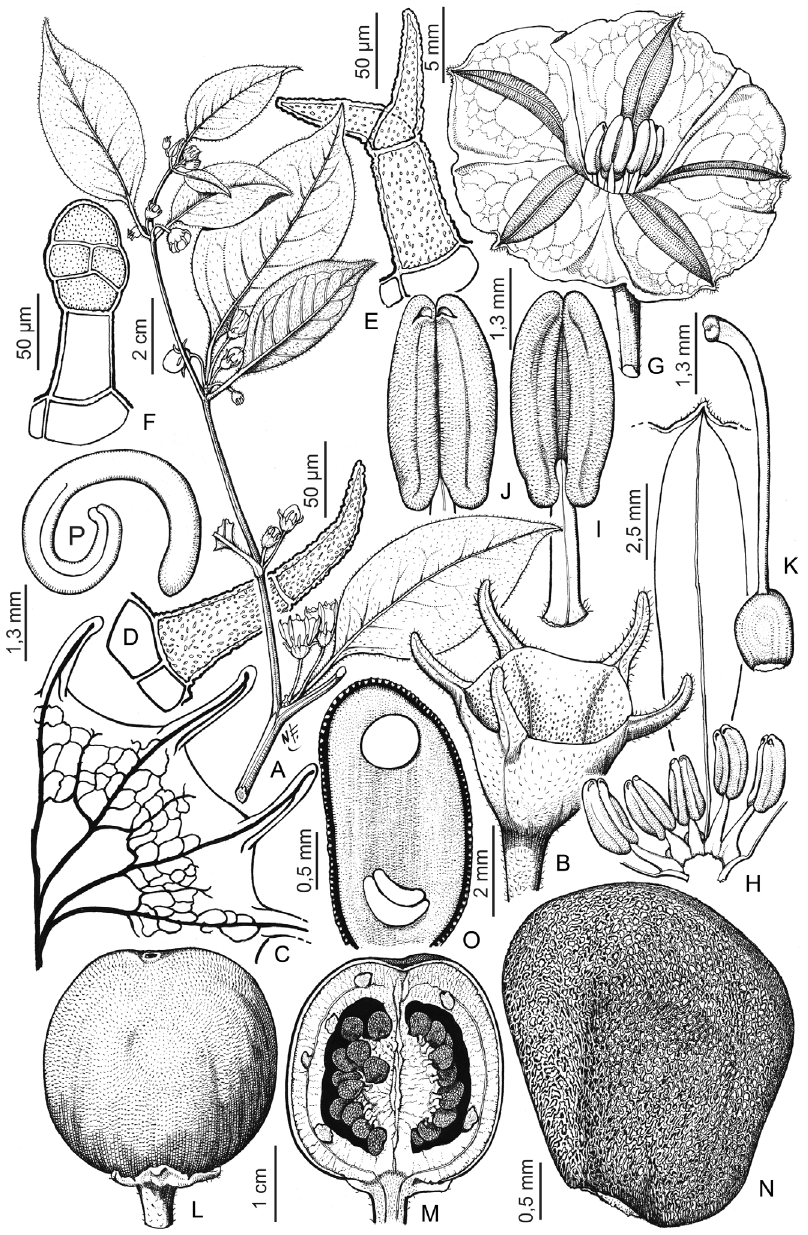
Figure 43. Lycianthes rantonnetii (Carrière) Bitter A flowering stem B five-toothed calyx with append- ages near the margins C calyx venation D simple uniseriate trichome E forked trichome F glandular papillate trichome G rotate corolla with abundant interpetalar tissue H androecium showing unequal anther lengths I abaxial anther surface J adaxial anther surface K gynoecium with minutely capitate stigma L berry M berry cross section showing stone cells embedded in the pericarp N seed with minutely pitted surface O cross section of seed. Reproduced from Barboza (2013). Courtesy of Flora Argentina, repro- duced with